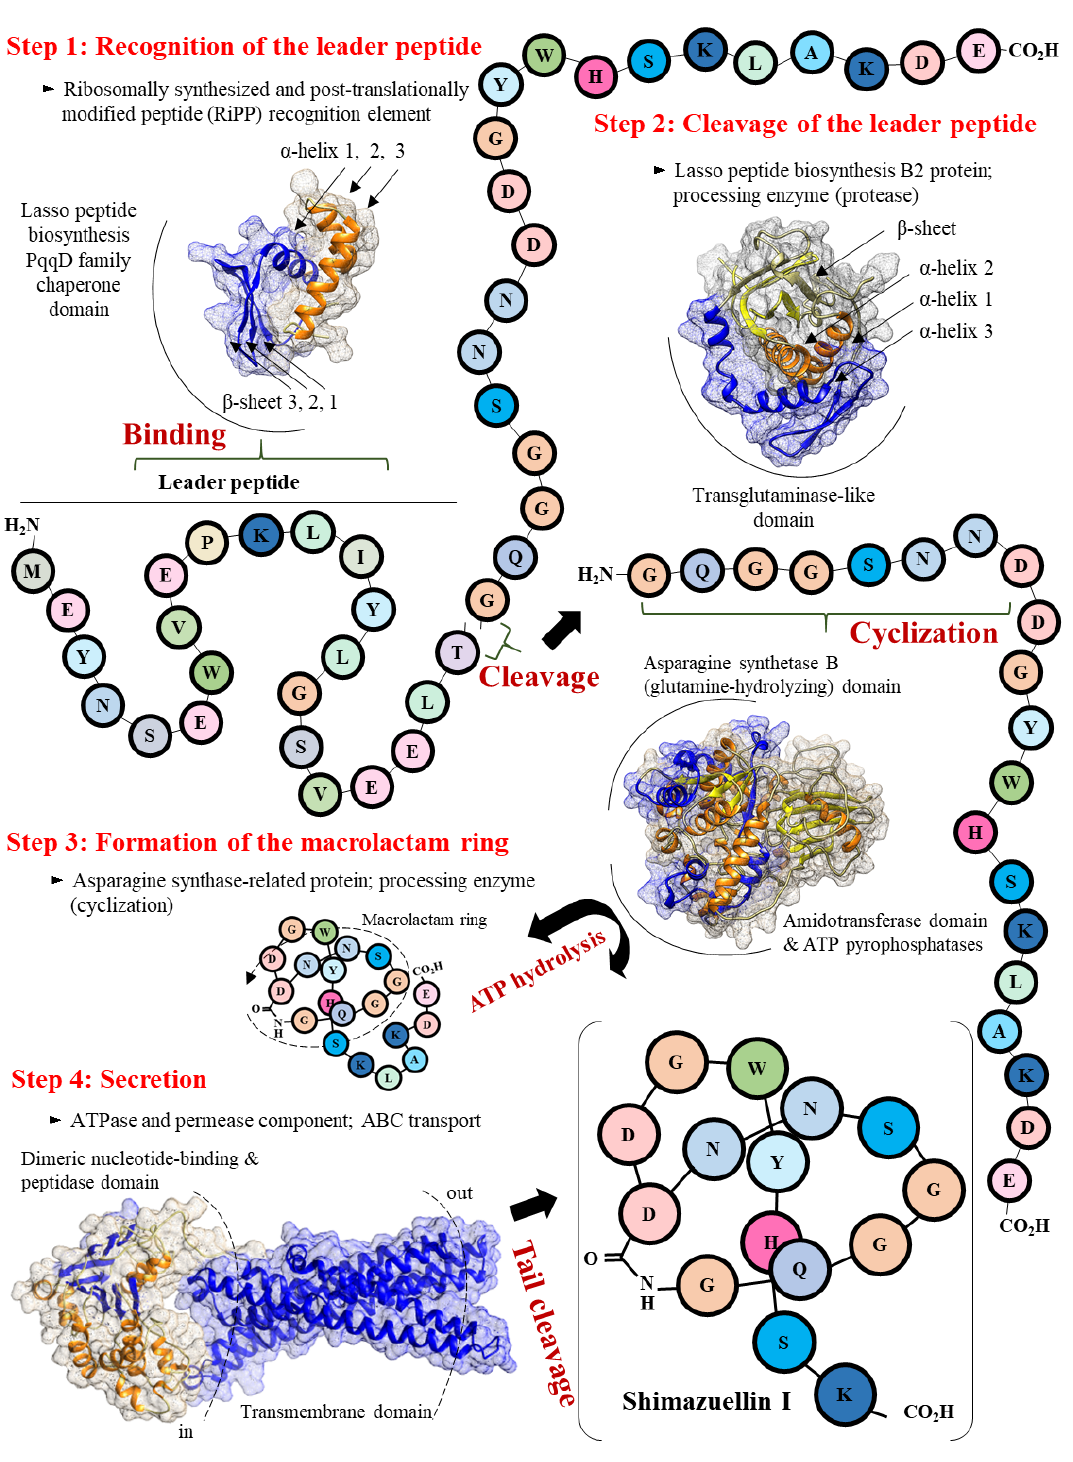
Figure 5. Proposed mechanism of shimazuellin biosynthesis and secretion, involving four steps.